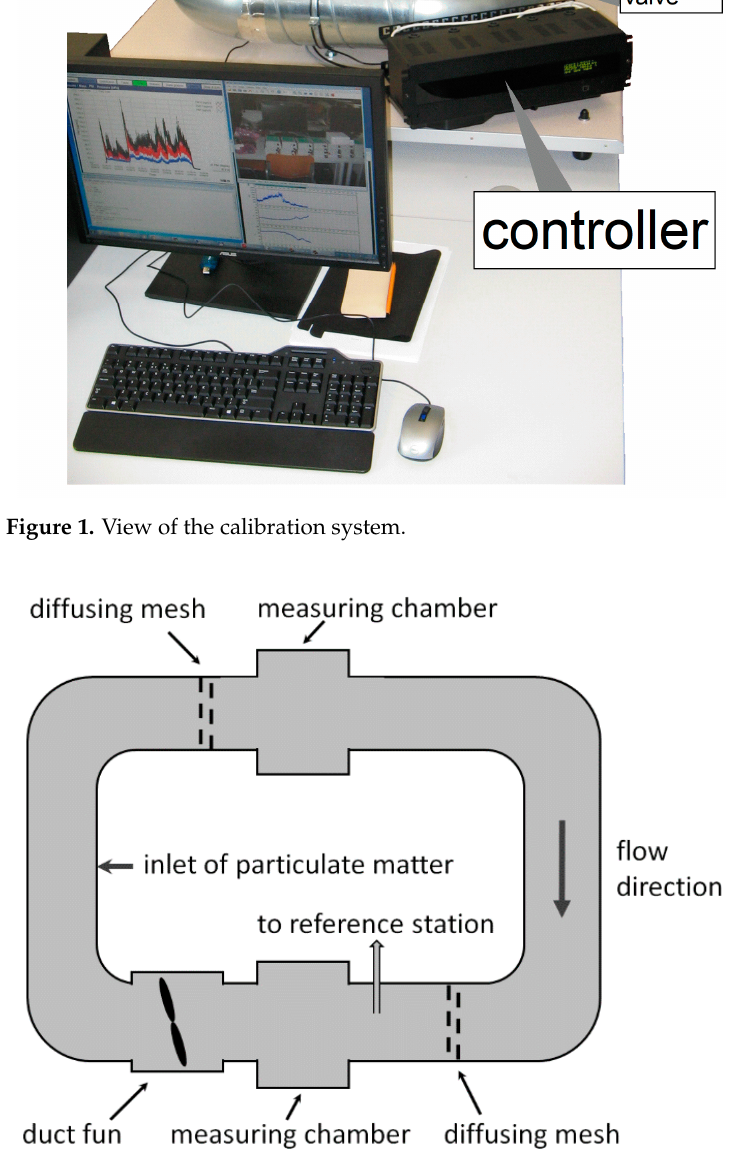
Figure 2. A simplified diagram of the